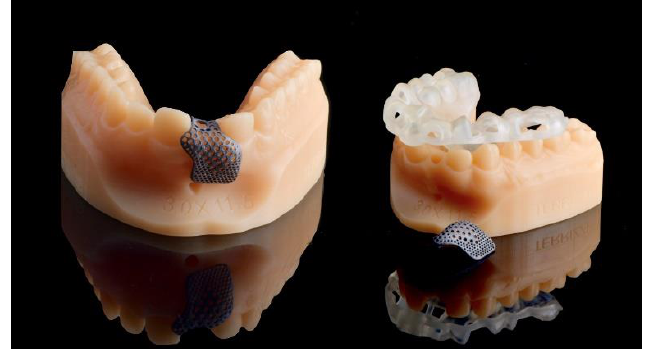
Figure 3. Computer-aided design (CAD) of the customized titanium mesh based on the contralateral maxillary outline and OssBuilder (Osstem Implant Co., Ltd., Seoul, Korea) features.